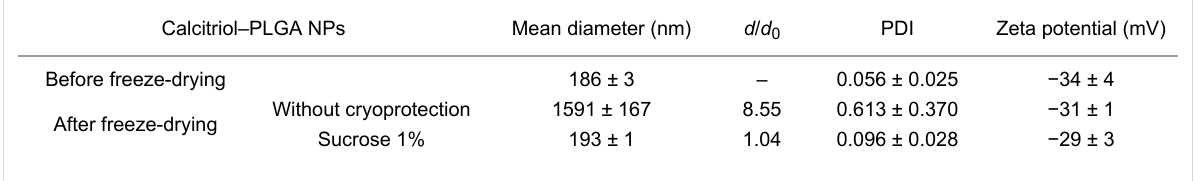
Table 2: PLGA NPs physicochemical characterization after freeze-drying experiments, with and without a cryoprotective agent. The mean size varia- tion is expressed in terms of the ratio d / d 0 , where d is mean diameter after freeze-drying and d 0 is the initial NP mean diameter. The data is presented as the mean ± SD ( n =